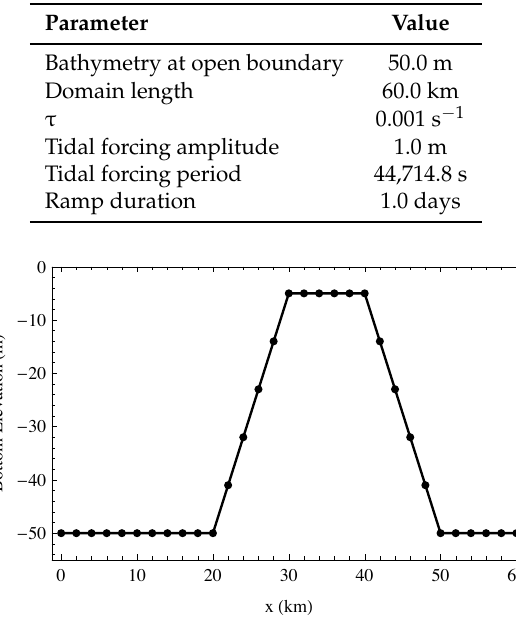
Figure 4. Bathymetry and node locations for the seamount